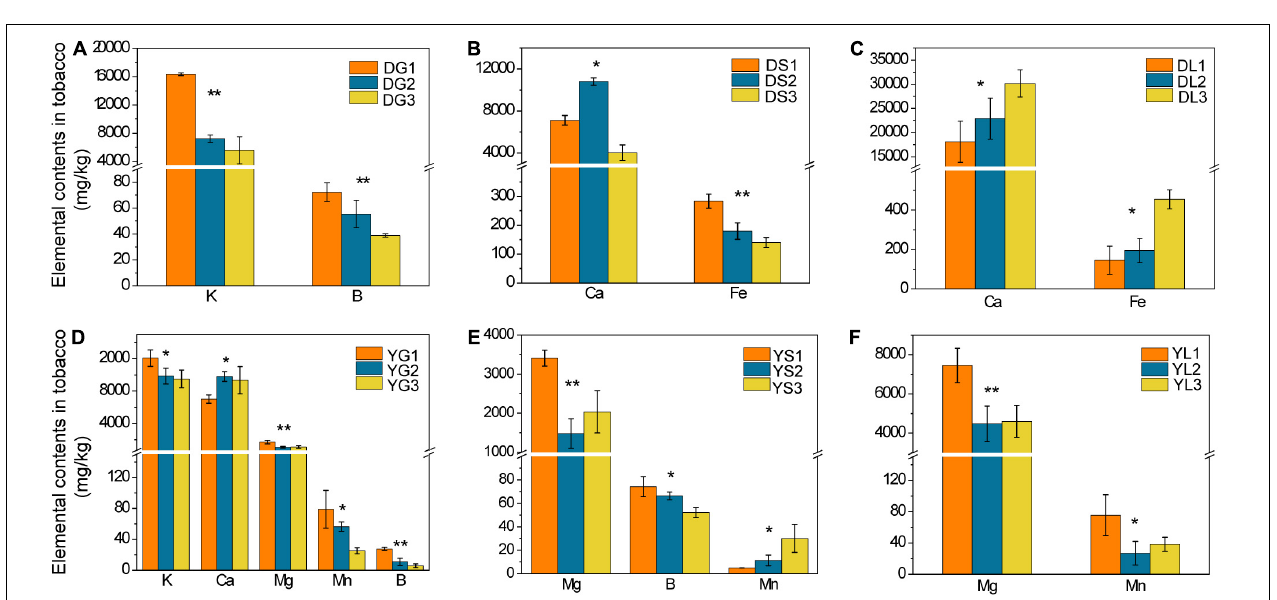
FIGURE 1 | The elemental contents in the topsoil from Dali (A) and Yuxi (B) and in the rhizosphere soil from Yuxi (C) . Values are the average of three replicates with a standard deviation bar. D1, D2, and D3 represent the topsoil in non-, slightly, and severely diseased groups from Dali, respectively. Y1, Y2, and Y3 represent the corresponding samples from Yuxi; those followed by “R” represent the corresponding rhizosphere soil. “**” and “*” represent the contents of the elements showing extremely significant ( p < 0.01) and significant ( p < 0.05) difference, respectively.